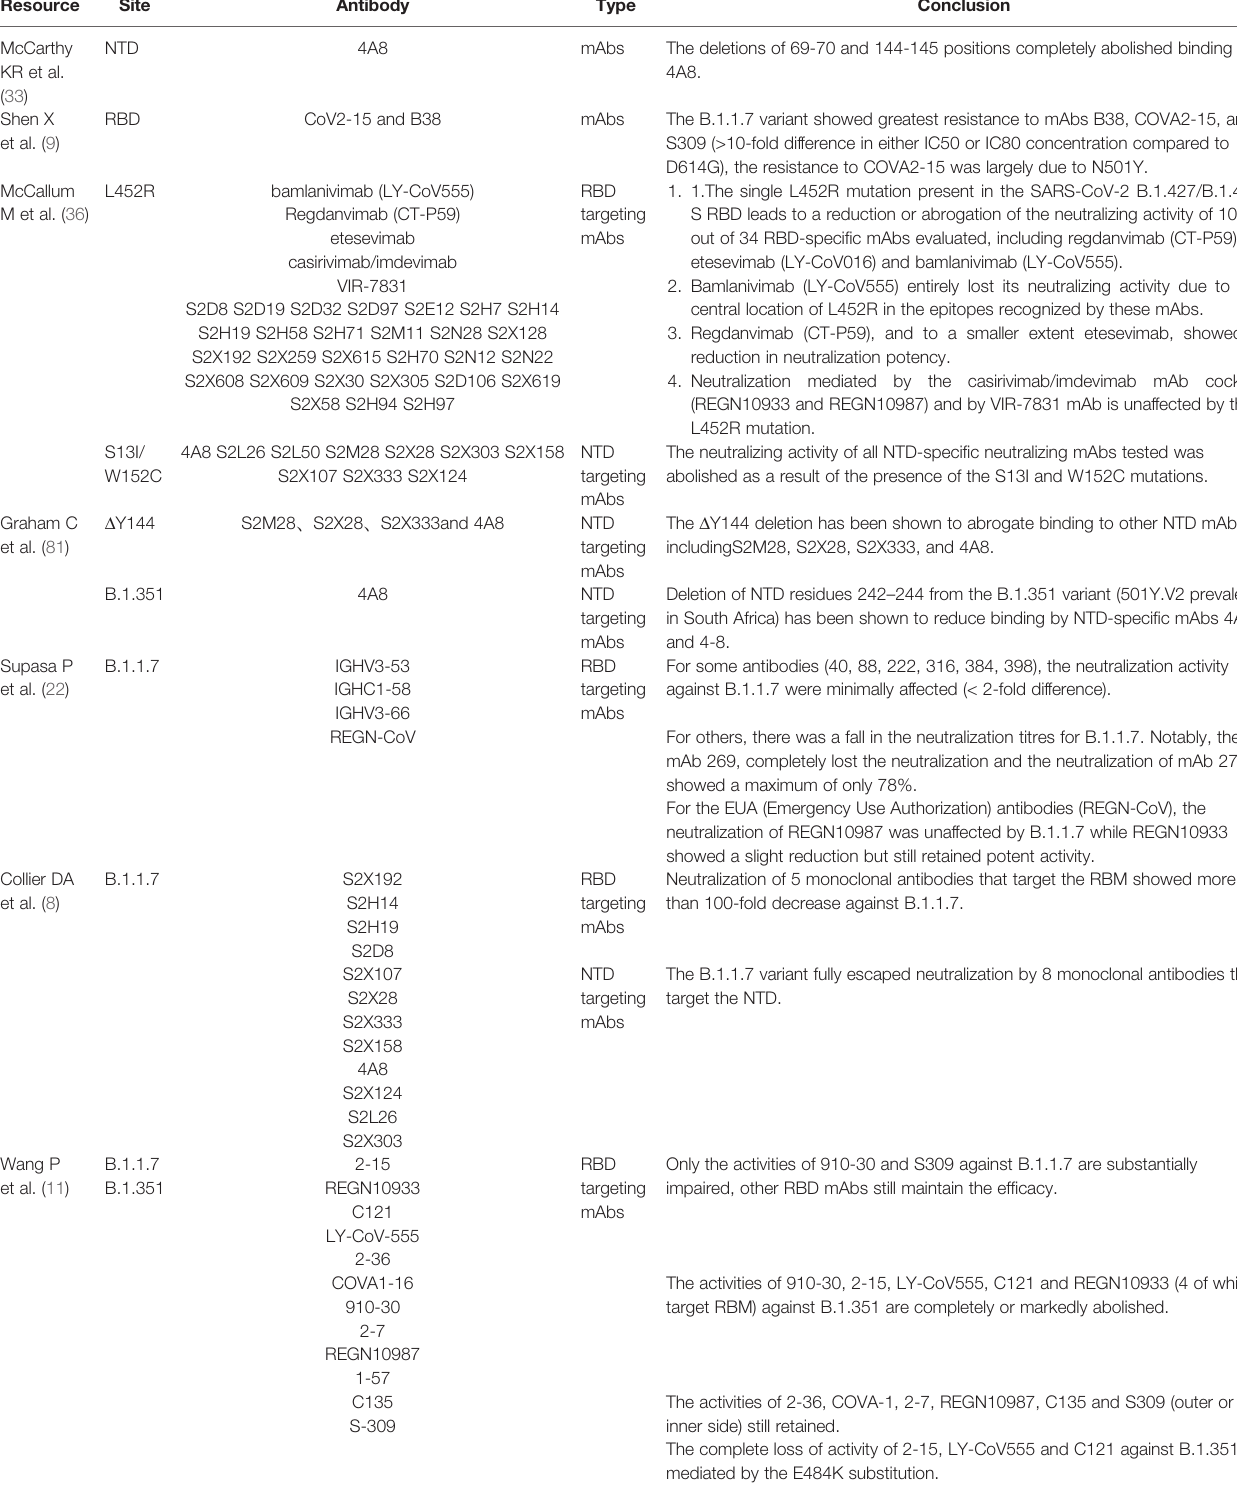
TABLE 3 | The ef fi cacy of antibodies against several prevalent